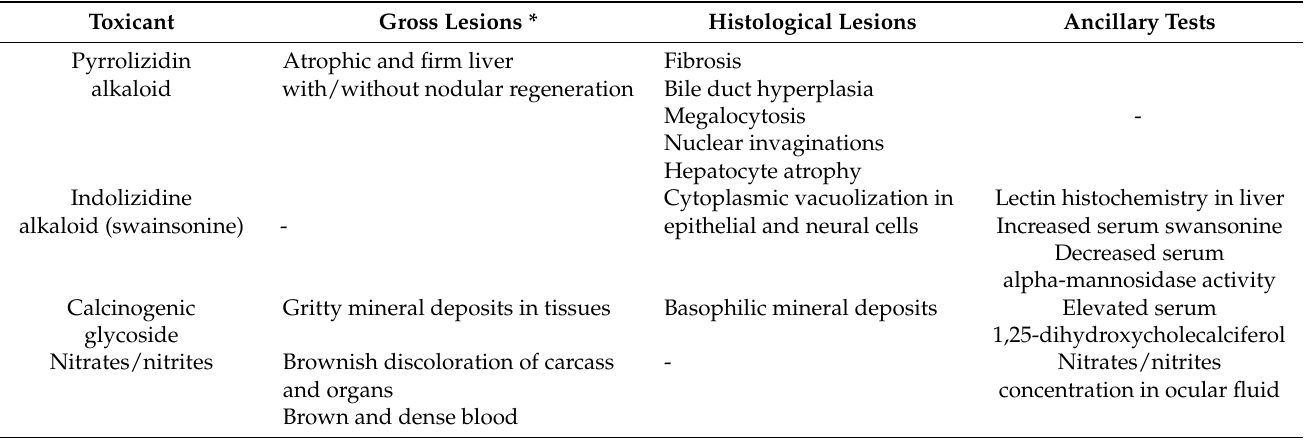
Table 2. Diagnostically relevant lesions and ancillary tests for plant-derived